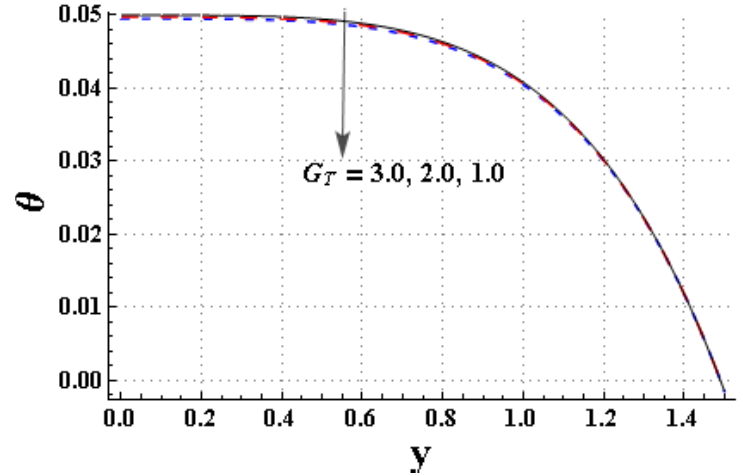
G G , on temperature,  . , on temperature,  .